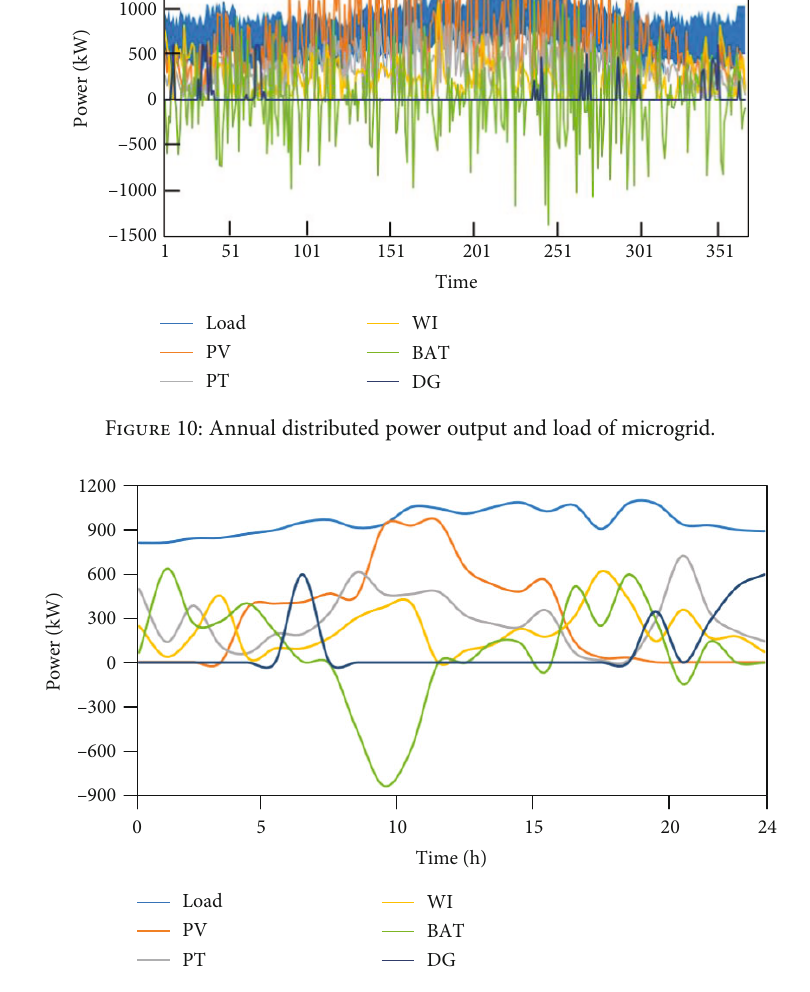
Figure 11: Typical daily distributed power supply output and load of